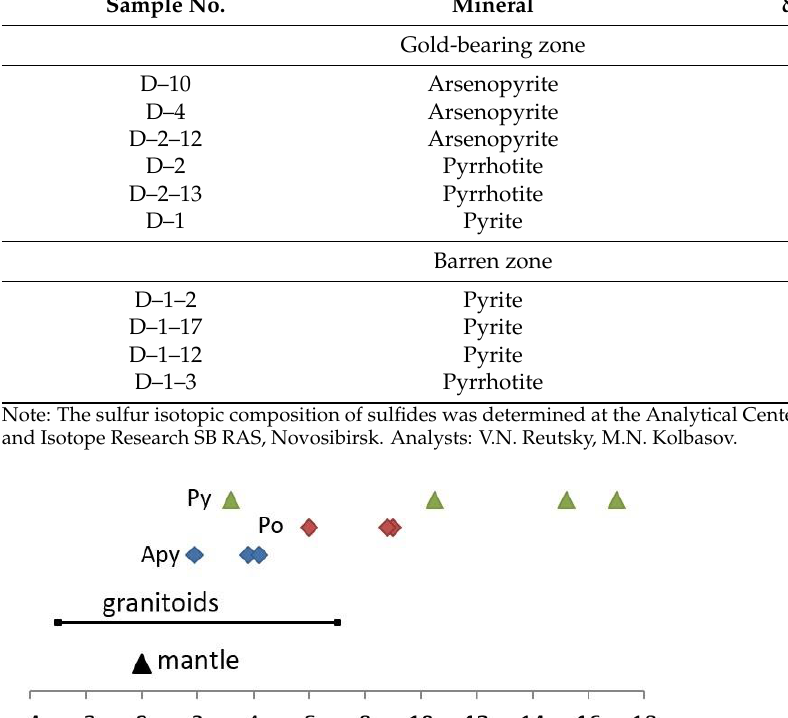
Table 5. Sulfur isotopic composition of sulfides from the Dobroe gold deposit. Sample No.